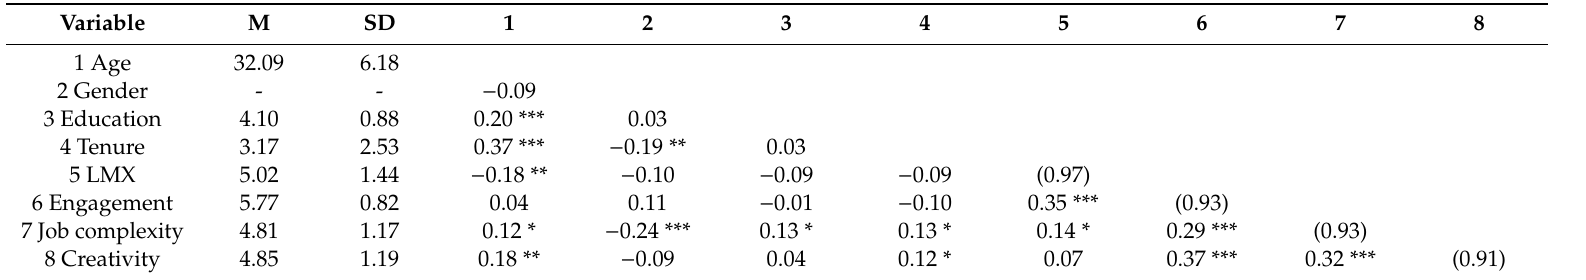
Table 1. Descriptive statistics, correlations, and reliability coe ffi